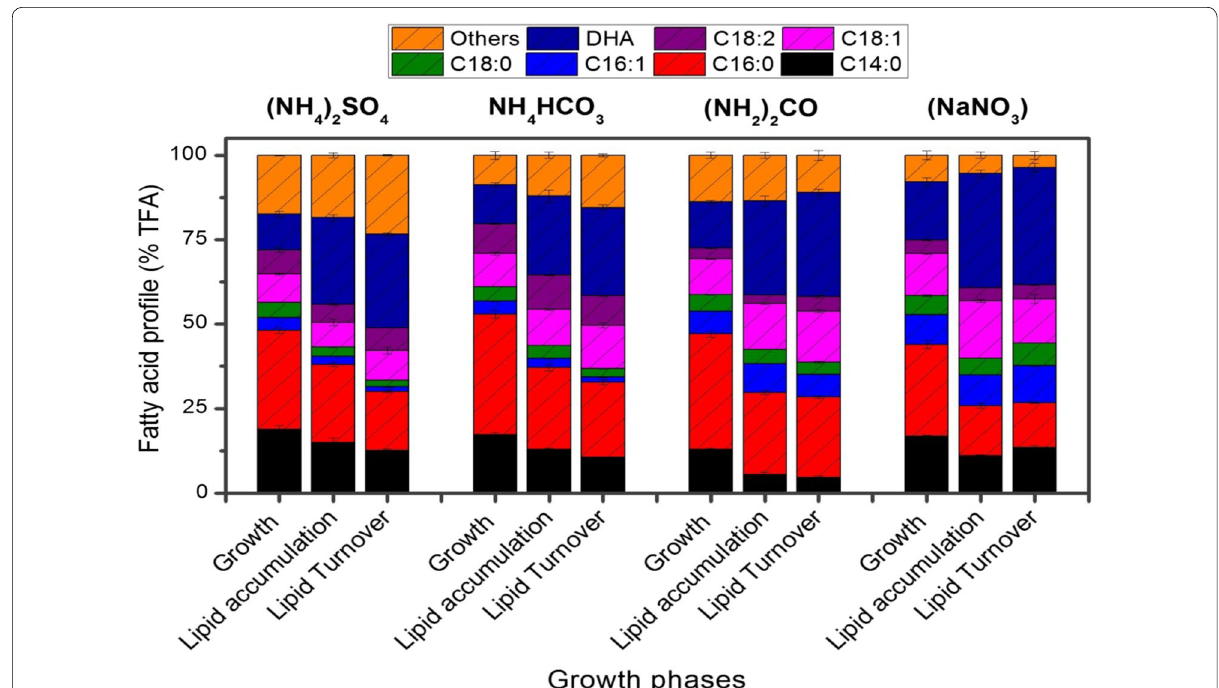
Fig. 3 Fatty acid profile (% total fatty acid) of C. Cohnii under different N-sources in three growth stages; cell growth, lipid accumulation and lipid turnover stage, harvested on 48, 120 and 168 h, respectively. All experiments were performed in triplicate. The data presented here is mean